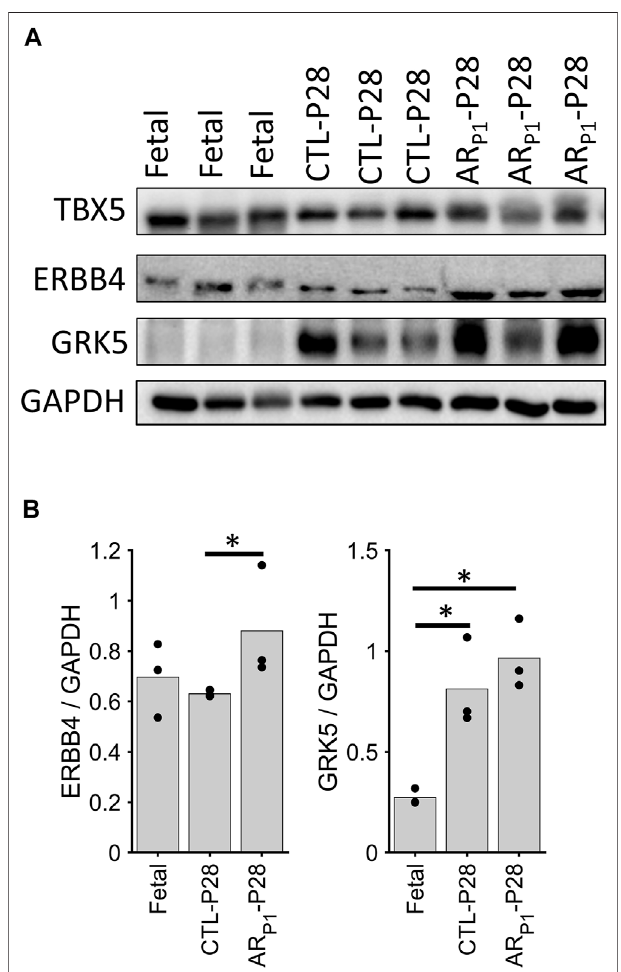
FIGURE 6 | Western blotting con fi rming ERBB4 and GRK5 expression. The expression in each sample was scaled according to GAAPDH level to ensure equal loading. (A) Representative Western Blotting image in each group. Each row presents a protein, in order: ERBB4, and GRK5. Each column presents a sample, in order: Fetal (3 samples), CTL-P28 (3 samples), and AR P1 -P28 (3 samples). (B) Bar chart comparing the average expression among groups. Here, the value for each sample is represented in a circle dot. The horizontal lines and stars (*) represent nonparametric statistical comparisons between two groups. * p -value <